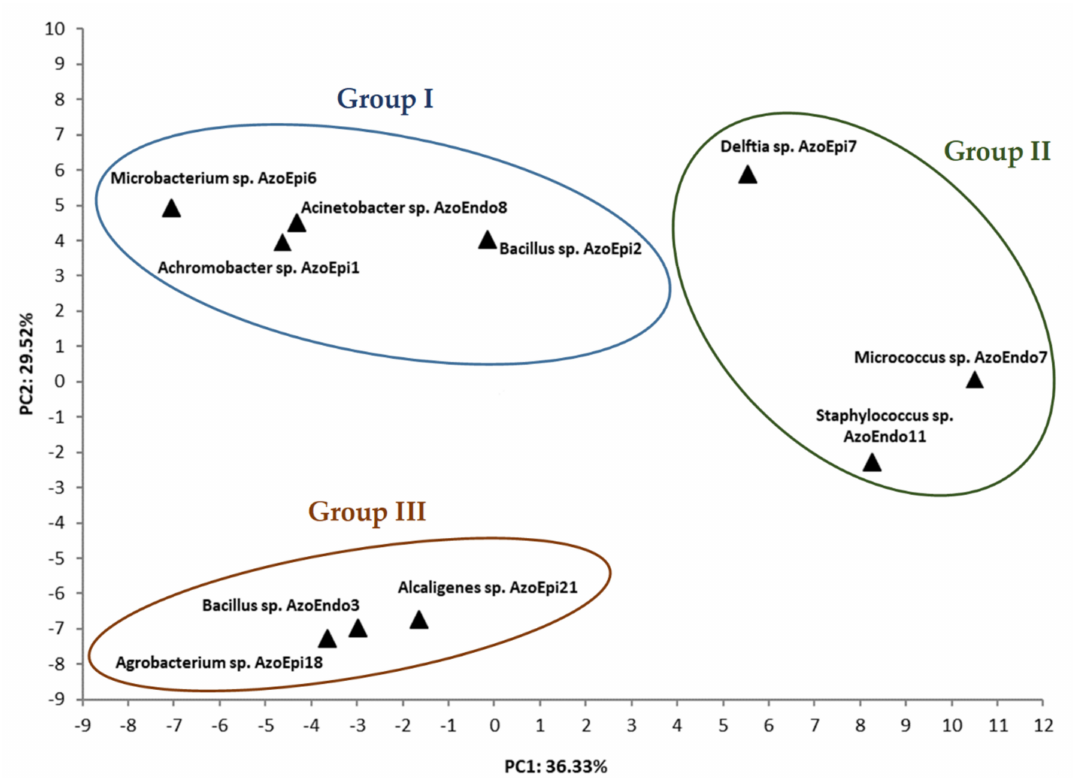
Figure 4. Principal components analysis (PCA) of the Biolog GEN III system for the studied strains after 48h of incubation at 30 ◦ C on GEN III MicroPlates ™; Principal Component 1 (PC1) plotted against Principal Component 2 (PC2) generated by PCA shows the different patterns of 71 carbon sources and 23 susceptibility factors in the studied